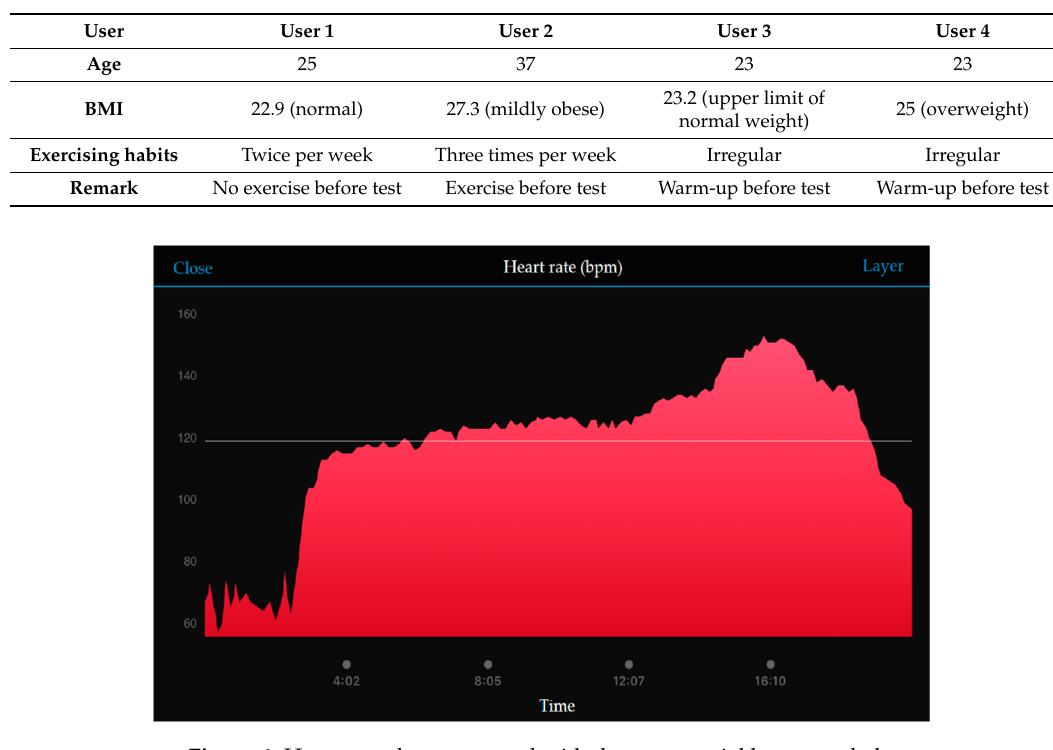
Figure 6. Heart rate data measured with the commercial heart rate belt.